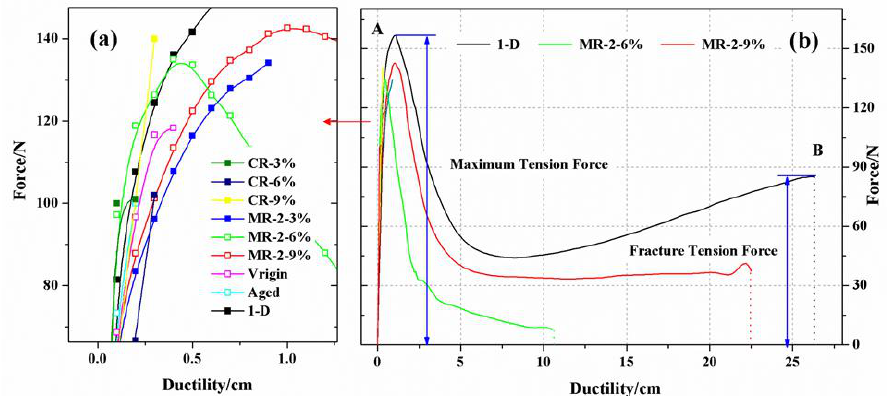
Figure 11. Force–ductility curves for the aged asphalt, virgin asphalts, and rejuvenated asphalts at a temperature of 5 ◦ C: ( a ) The enlarged image of the beginning stretch section of the force–ductility curves; ( b ) The complete force–ductility curves image of the 1-D, MR-2-6%, and MR-2-9% samples at a temperature of 5 ◦ C. Table 7. Force–ductility analysis results for the aged, virgin, and rejuvenated asphalt binders. Sample